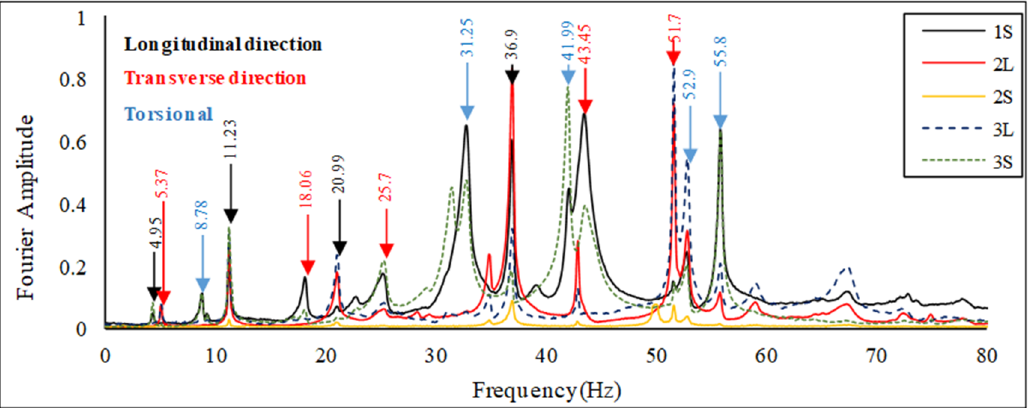
Figure 8. FFT of responses for various sensors averaged over the different cases.